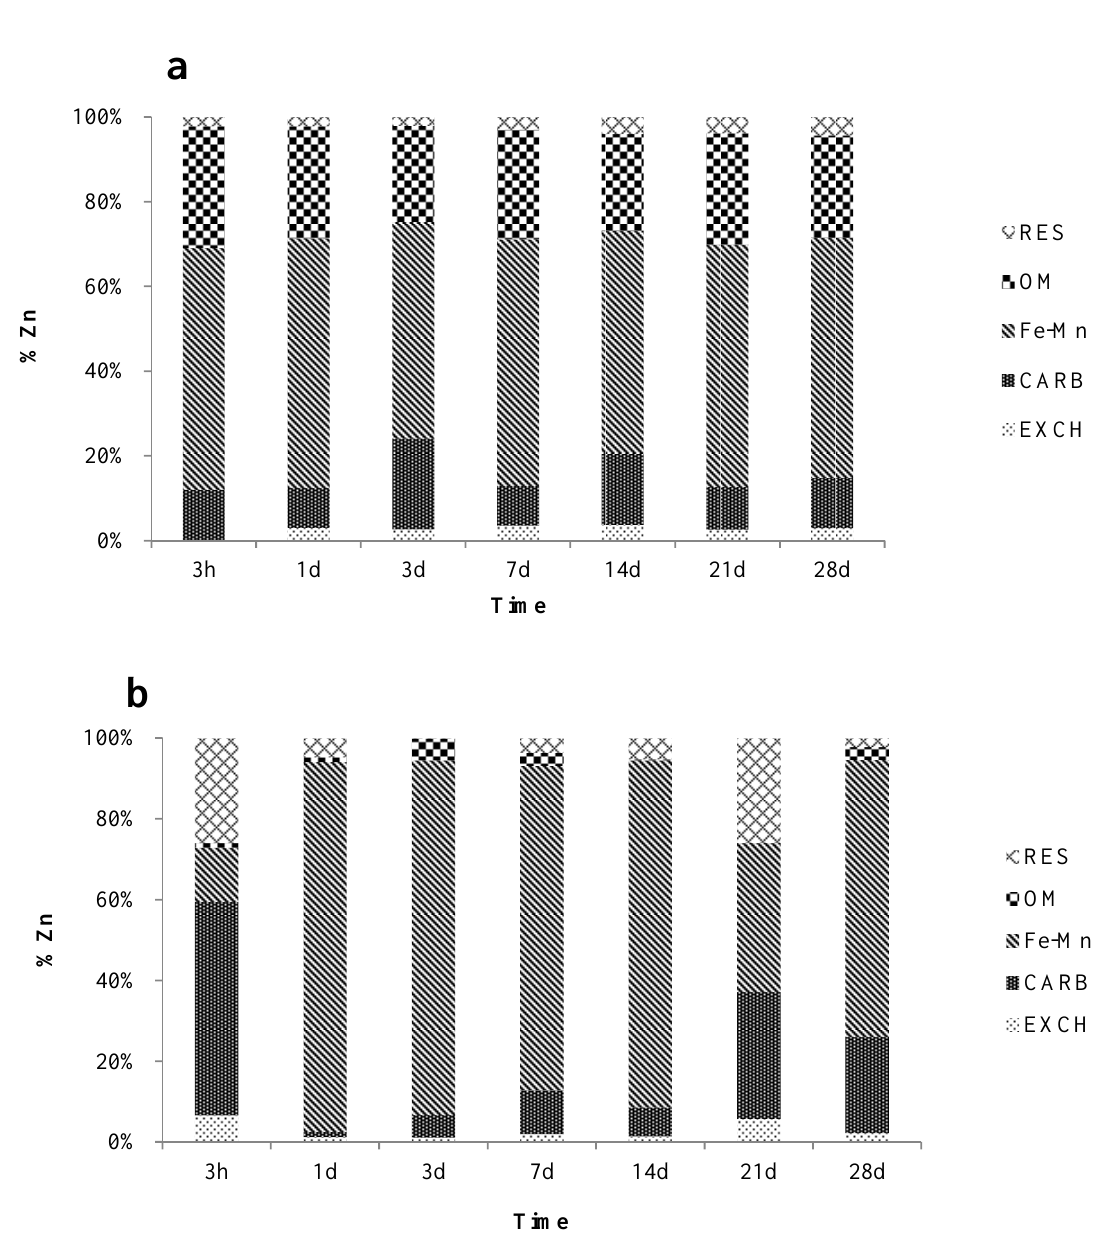
Figure 2. The change of Zn (%) in different fractions with time in contaminated soil with (a) Actinidia deliciosa shell (b) in control soil Table 6. Concentration (mg/ kg) of Zn in each fraction in the contaminated soil with Actinidia deliciosa shell Time Exchangeable Carbonate Fe-Mn oxides occluded Organic matter